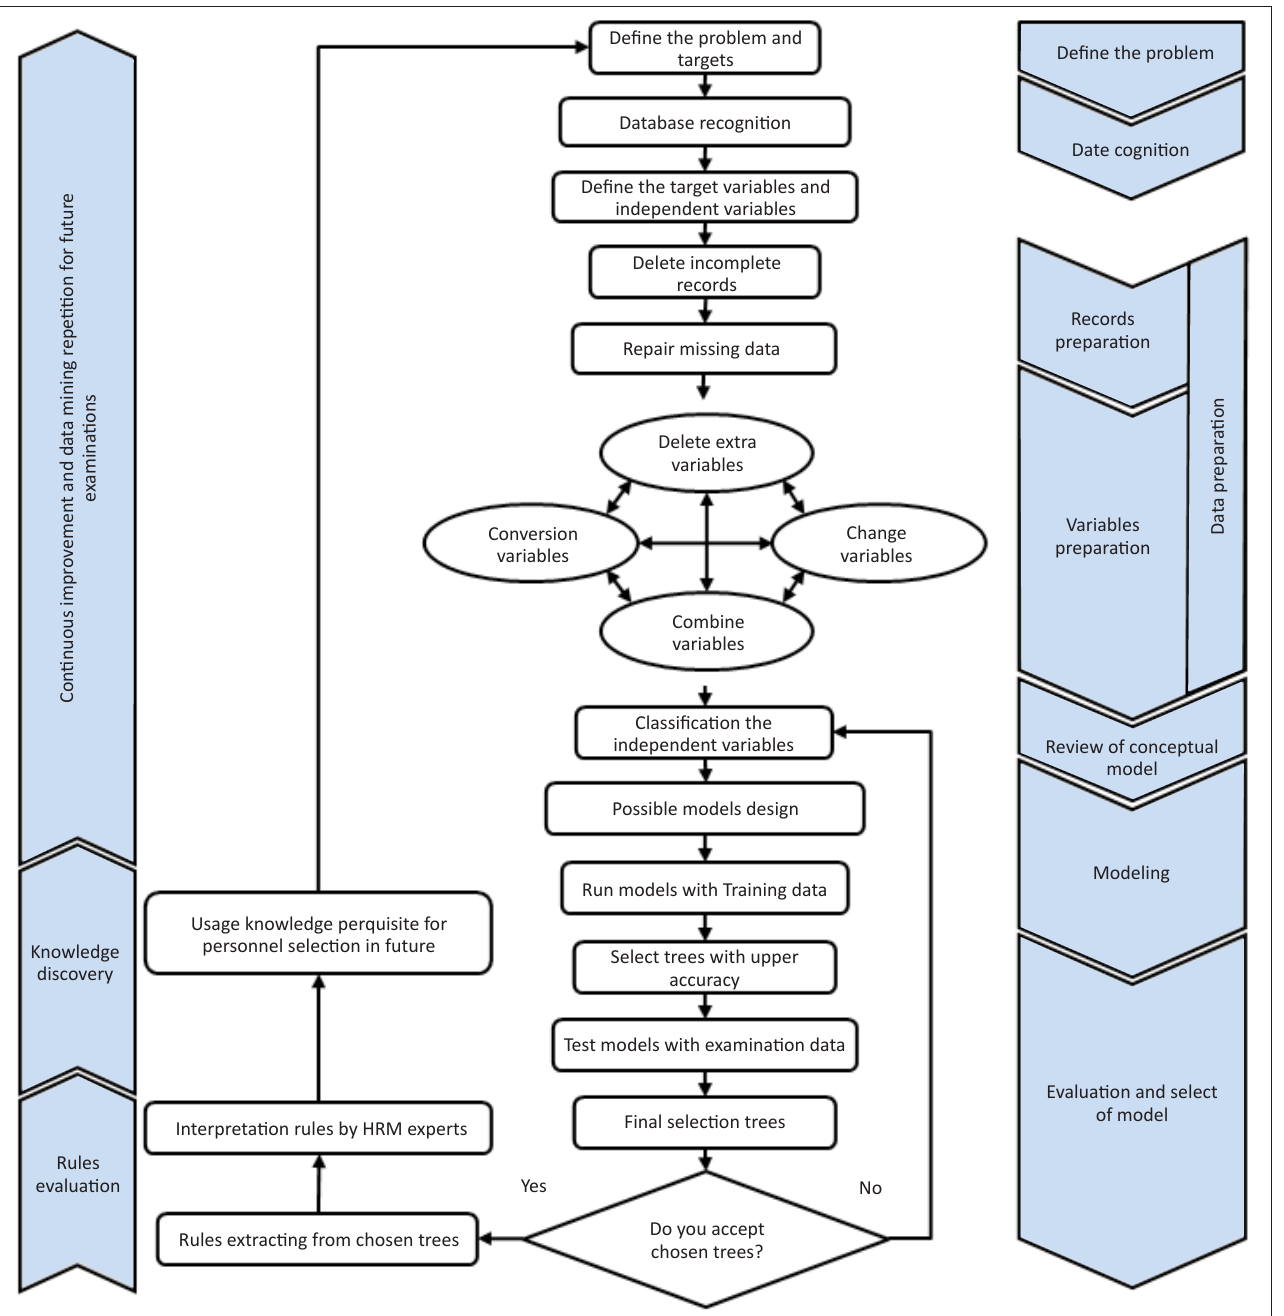
FIGURE 2: Knowledge discovery model from database of entrance examinations with data